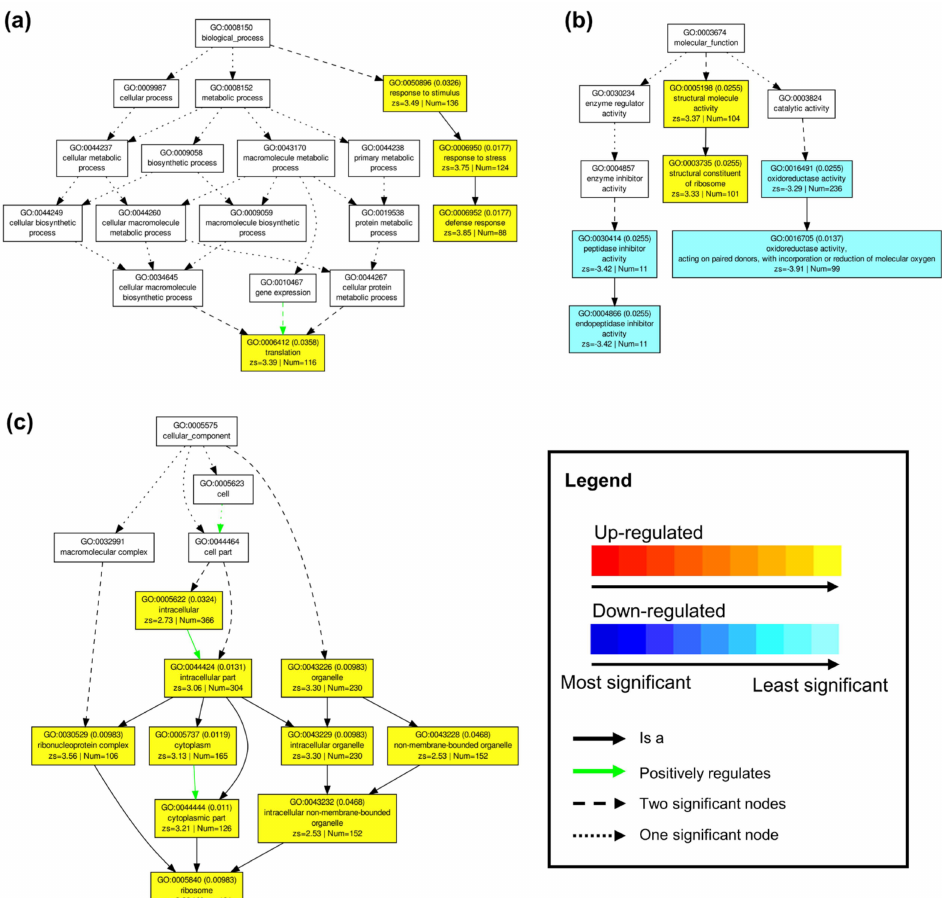
Figure 3. PAGE analysis of differentially expressed genes between drought-treated ‘sativa’ and ‘falcata’ genotypes. ( a ) Bi- ological process GO term category. ( b ) Molecular function GO term category. ( c ) Cellular component GO term category. Analyses were carried out using AgriGO v2.0 using the Hochberg (FDR) multi-test adjustment method and a significance level of